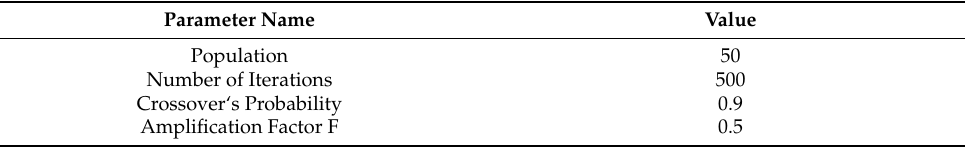
Table 7. The differential evolution parameters used in the